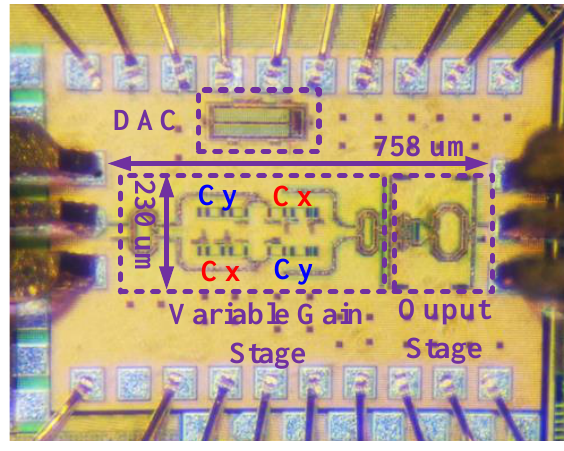
Figure 6. Micrograph of the proposed VGA.